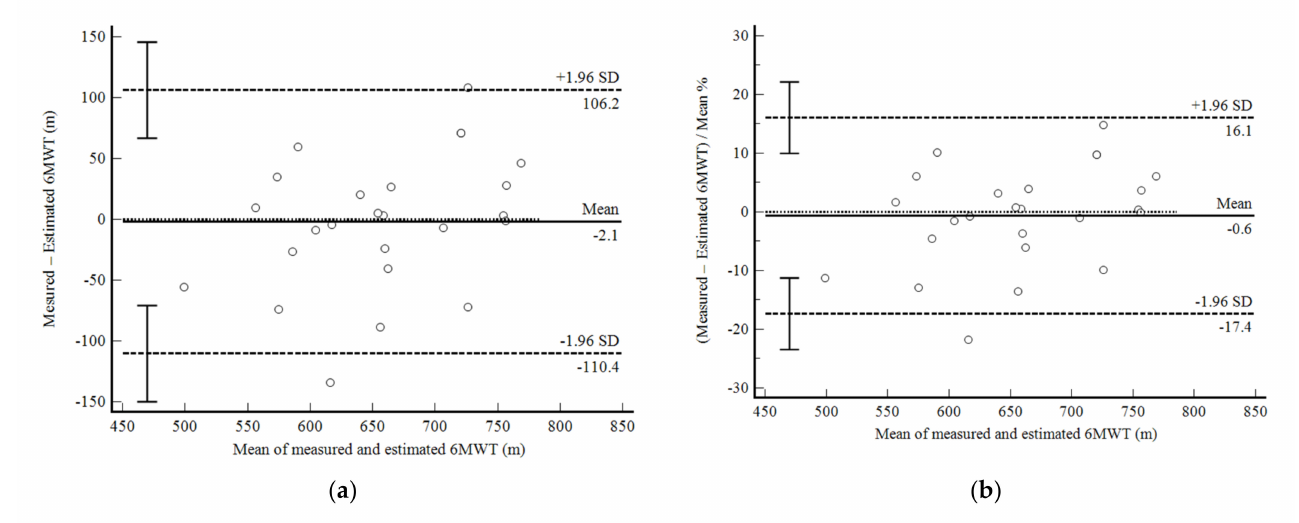
Figure 1. Bland and Altman graphic method with limits of agreement and 95% confidence interval (95%CI) between the measured and estimated six-minute walk test (6MWT) using the equation developed in the present study (Phase 1). ( a ) absolute values; ( b ) percentage values.